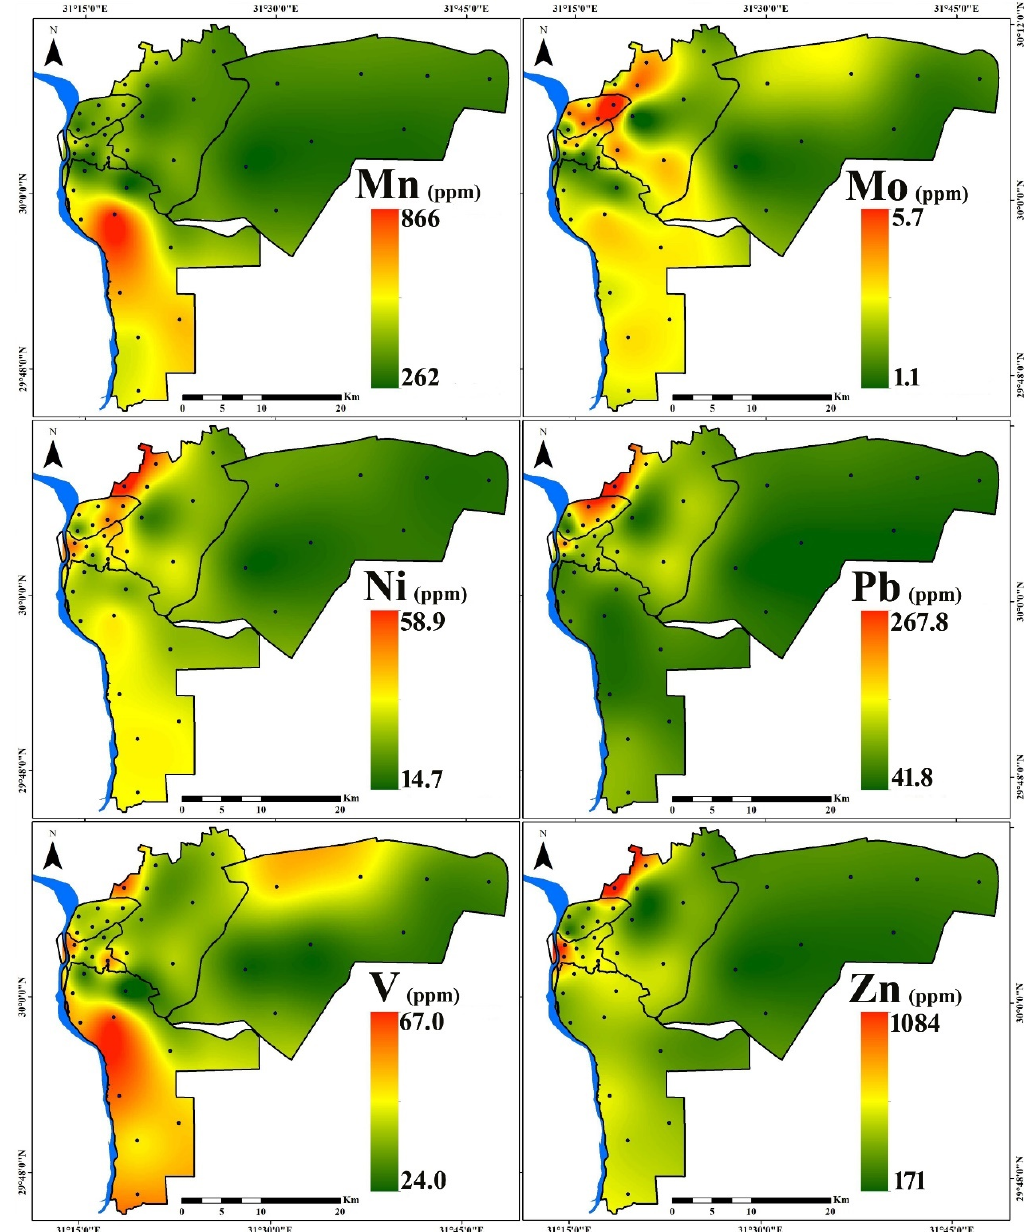
Figure 2. Spatial distribution of PTEs in household dust in Cairo City. To put the levels of PTEs in Cairo’s indoor dust into perspective, they were compared with the levels of the same elements in indoor dust worldwide (Table 3). Table 3 shows that the mean PTE concentrations in our indoor dust samples were both higher and lower than those worldwide. For instance, Al mean concentration was greater than those reported in Slovenia (Maribor) [63], Greece (Athens) [64], and USA (Texas) [7]. As was higher than those reported in Nigeria (Lagos) [22], Nepal [65], and USA (Texas) [7]. Cd was higher than those reported in Alexandria and Kafr El-Sheikh [45], Saudi Arabia (Riyadh) [1], Qatar (Doha) [66], Nigeria (Lagos) [22], Turkey (Istanbul) [67], Iran (Ahvaz) [60], and Greece (Athens) [64]. Cu was higher than those reported in Kafr El-Sheikh [45], Saudi Arabia (Riyadh) [1], Iraq (Al-Fallujah) [68], Nigeria (Lagos) [22], Iran (Ahvaz) [60], and USA (Texas) [7]. Fe was lower than Qatar (Doha) [66], Nigeria (Lagos) [22], and Canada (Alberta) [69]. Mn was far lower than China (Huize) [12] and Nepal [65]. Ni was higher than those reported in